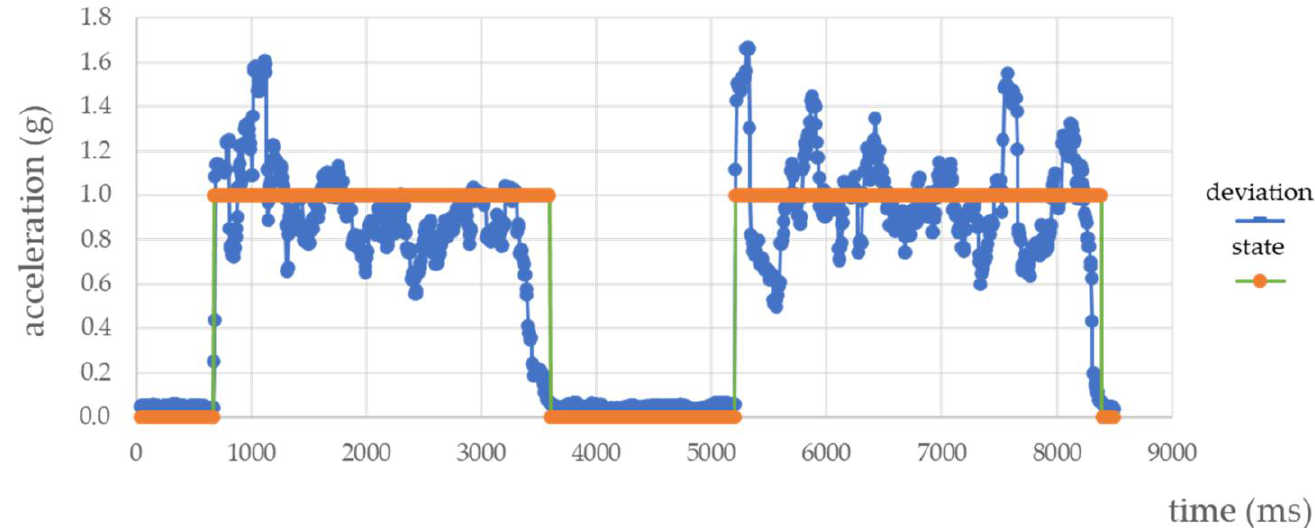
Figure 7. State calculation from deviation data.